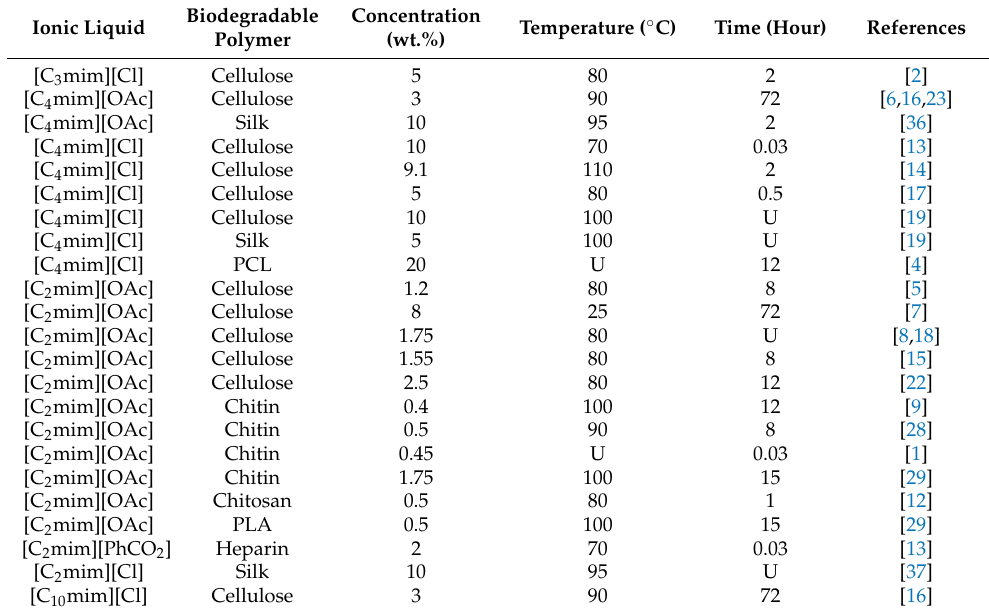
Table 5. Ionic liquids, biodegradable polymers, biodegradable polymer concentrations, dissolution temperatures, and dissolution times applied for the preparation of electrospinning